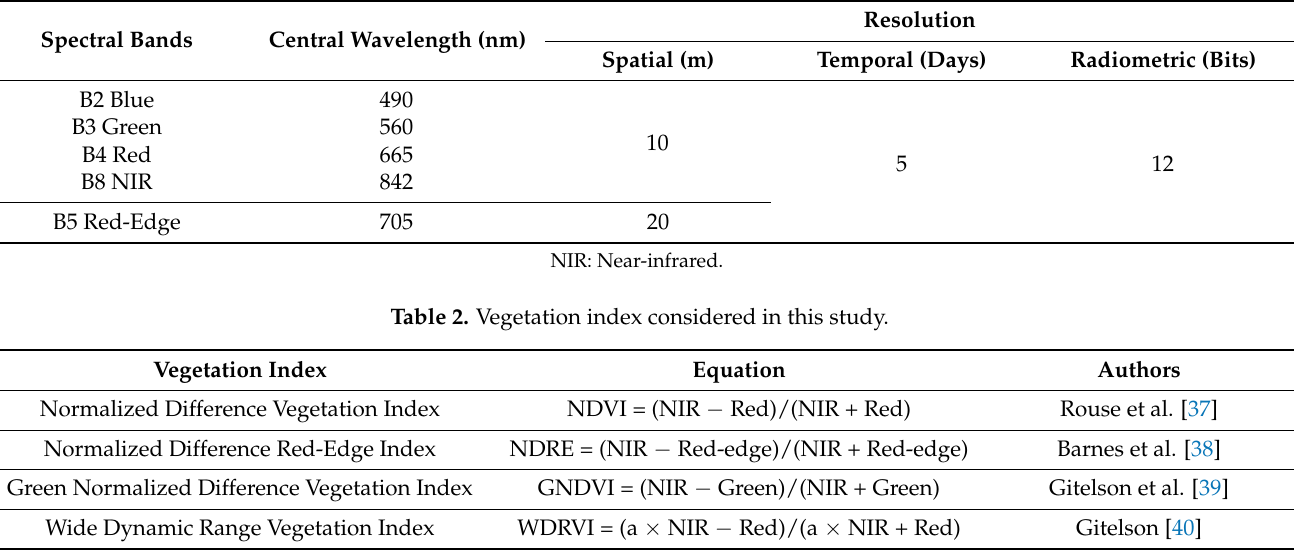
Table 1. Specifications of the spectral bands from Sentinel-2.